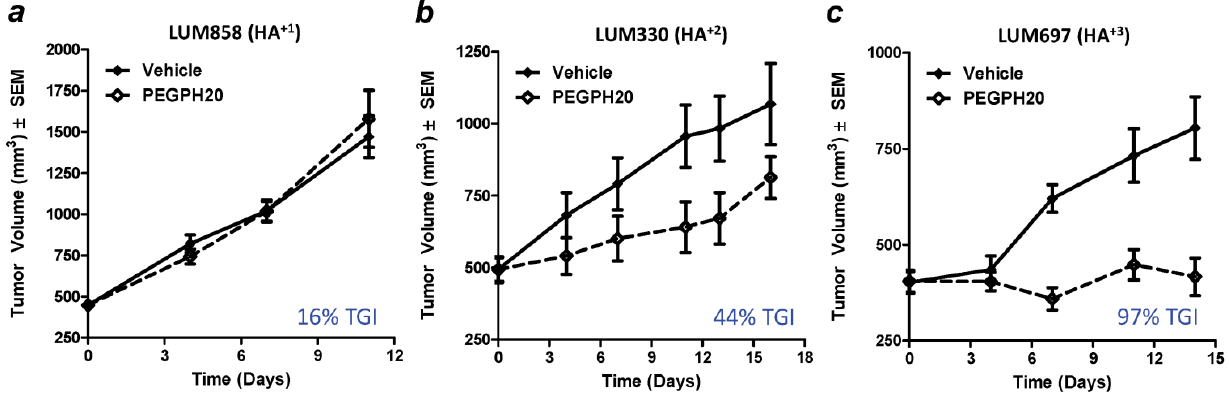
Figure 4. Impact of intravenous PEGPH20 treatment on tumor-associated HA in prostate cancer xenografts. Assessment of PEGPH20 and HA levels in PC3 xenografts harvested